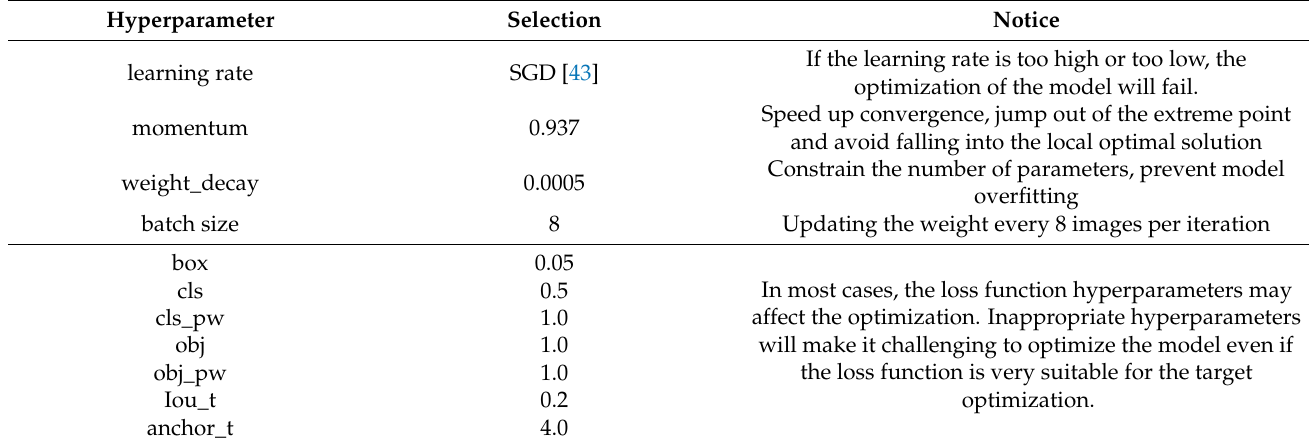
Table 3. The appropriate values for some hyperparameters and the effect of this hyperparameter setting on model